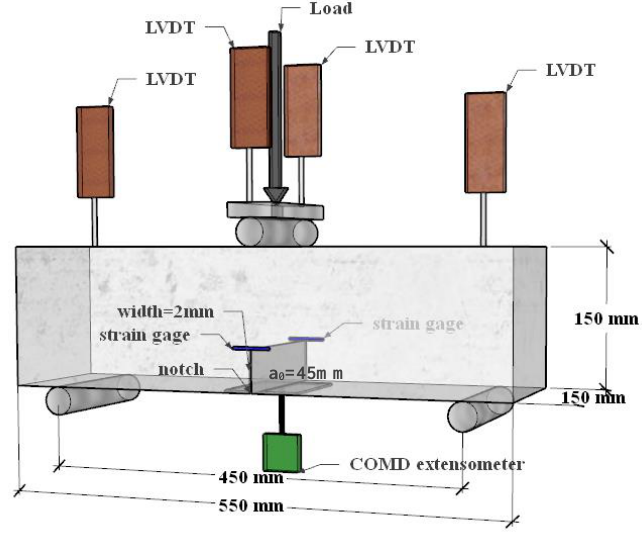
Figure 2. Experimental setup.